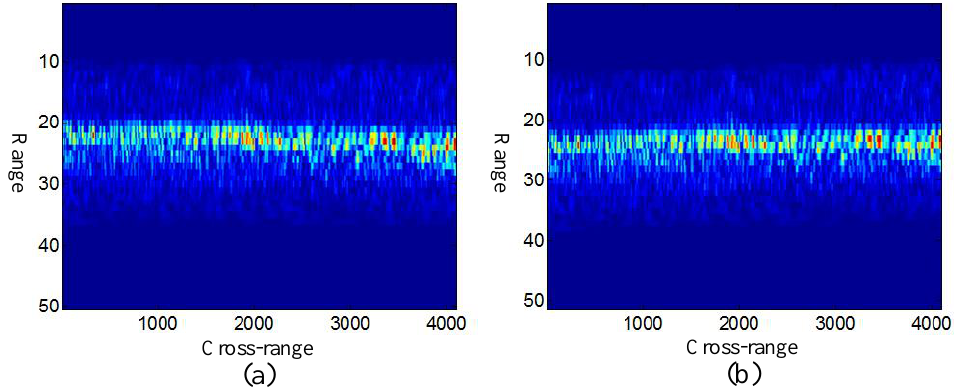
Figure 19. Moving target detection for T4. ( a ) Subaperture images before detection. ( b ) Subaperture images after detection.